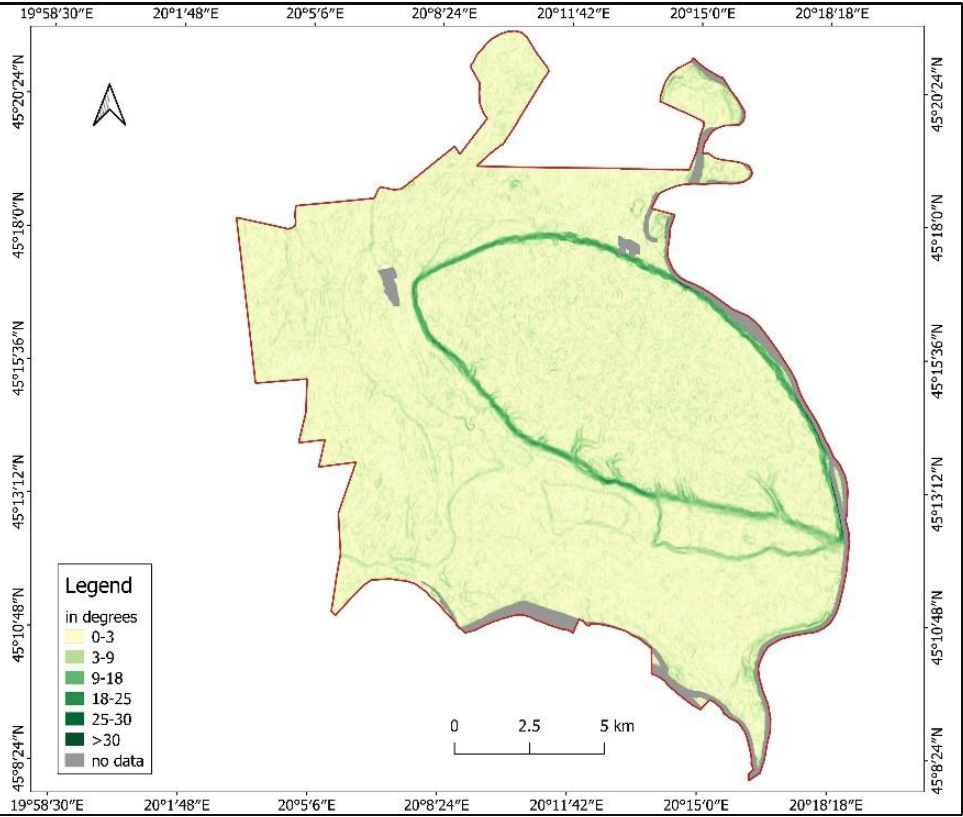
Figure 8. Slope map of the study area.